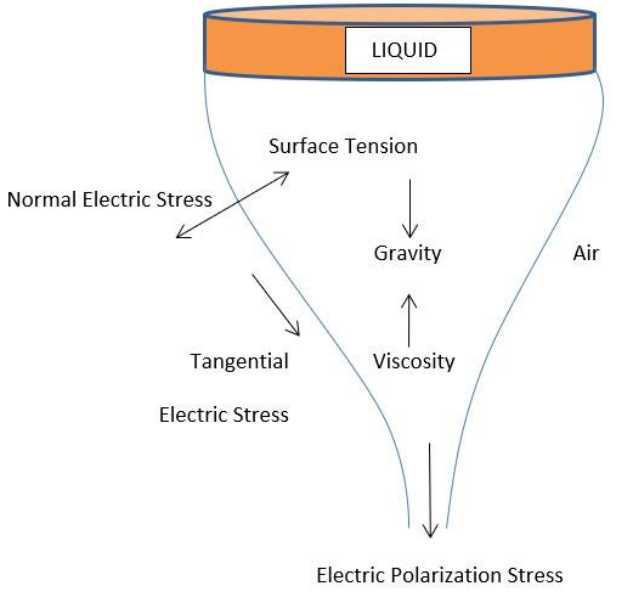
Figure 1. Diagrammatic description of forces active in nanofiber formation during electrospinning [11].